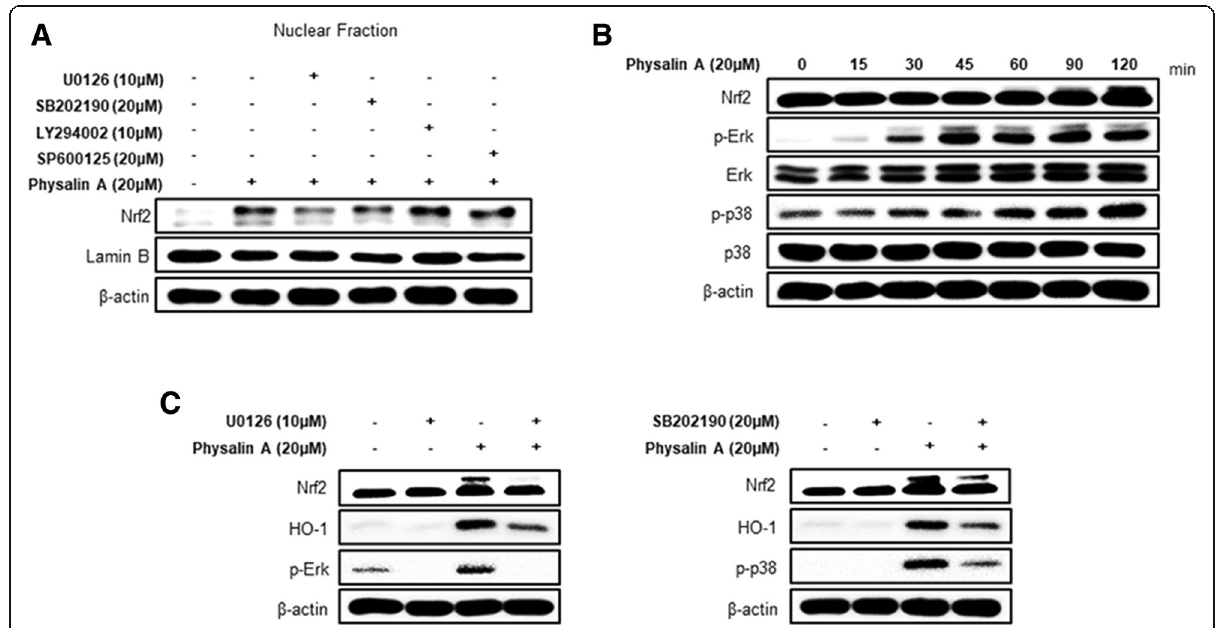
Fig. 6 Physalin A induces Nrf2 and target gene expression through ERK and p38 kinase activation. a Western blot analysis of Nrf2 expression in HepG2 cells pretreated with U0126 (MEK inhibitor), SB202190 (p38 inhibitor), LY294002 (PI3K inhibitor), and SP600125 (JNK inhibitor) for 1h, followed by treatment with 20 μ M physalin A for 4h. b Western blot analysis of phospho-ERK and phospho-p38 expression in HepG2 cells treated with 20 μ M physalin A for 0,